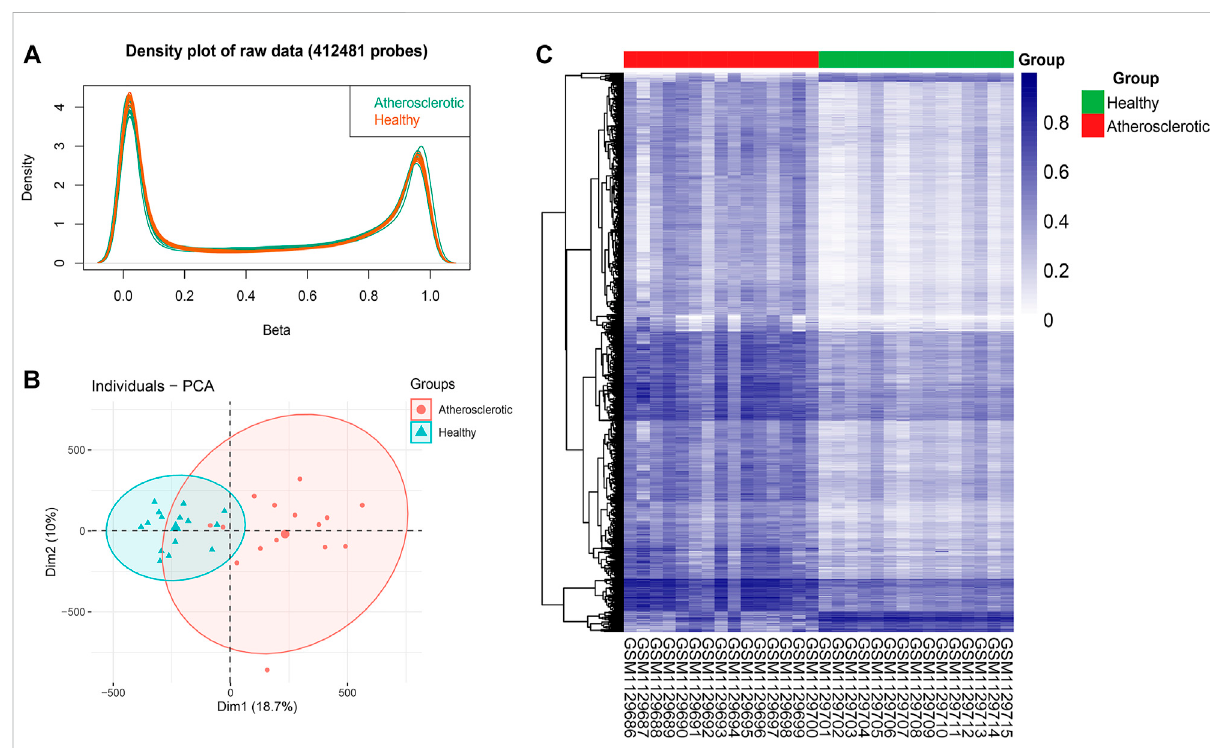
FIGURE 2 Identi fi cation of differential methylation positions (DMPs) in atherosclerosis. (A) Density plot of 412,481 probes ’ raw data. (B) Principal component analysis (PCA) of the normalized data in the atherosclerotic and healthy groups. (C) Heat map of DMPs with β -value variance in the top